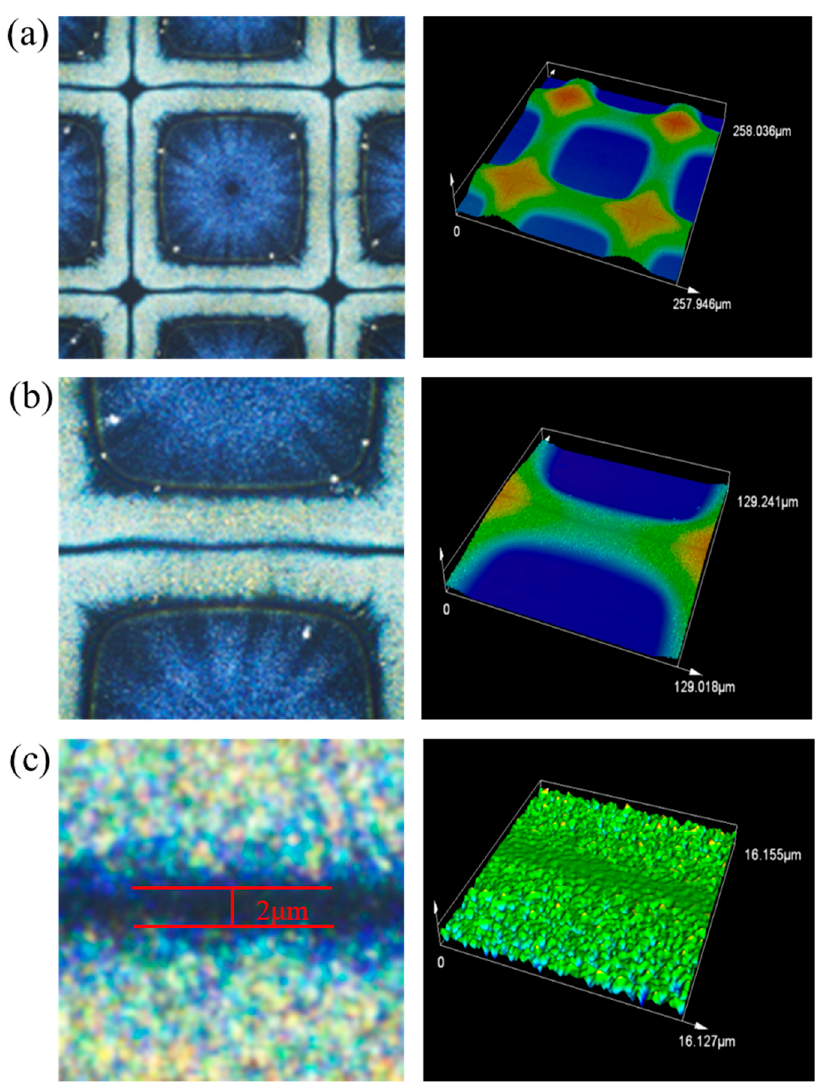
Figure 5. Confocal laser scanning microscopy images and 3D pictures captured under different magnifications: ( a ) 1127×, ( b ) 2254×, and ( c ) 18,031×.